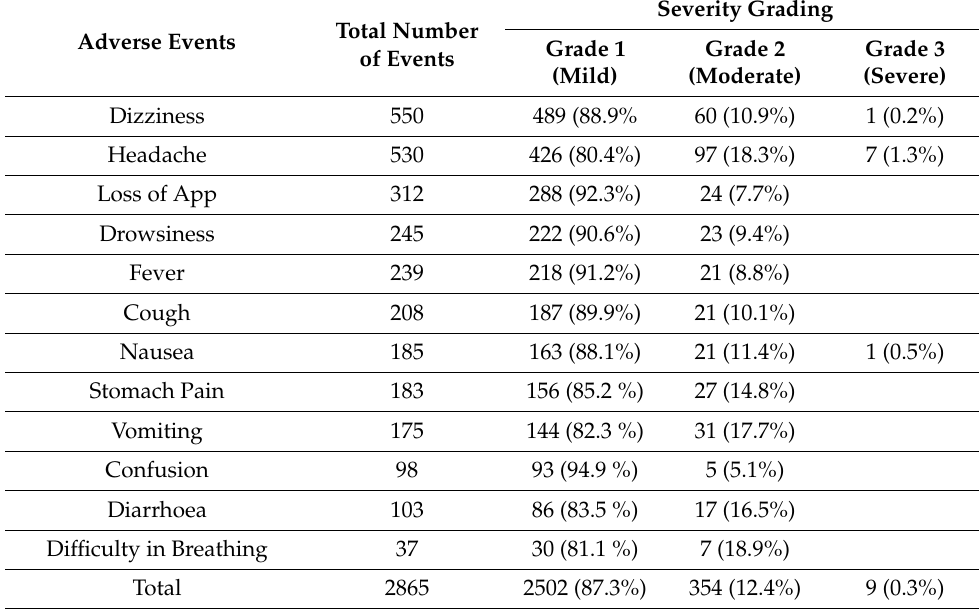
Table 2. Severity grading of adverse events following mass diethylcarbamazine and albendazole administration for control of lymphatic filariasis.